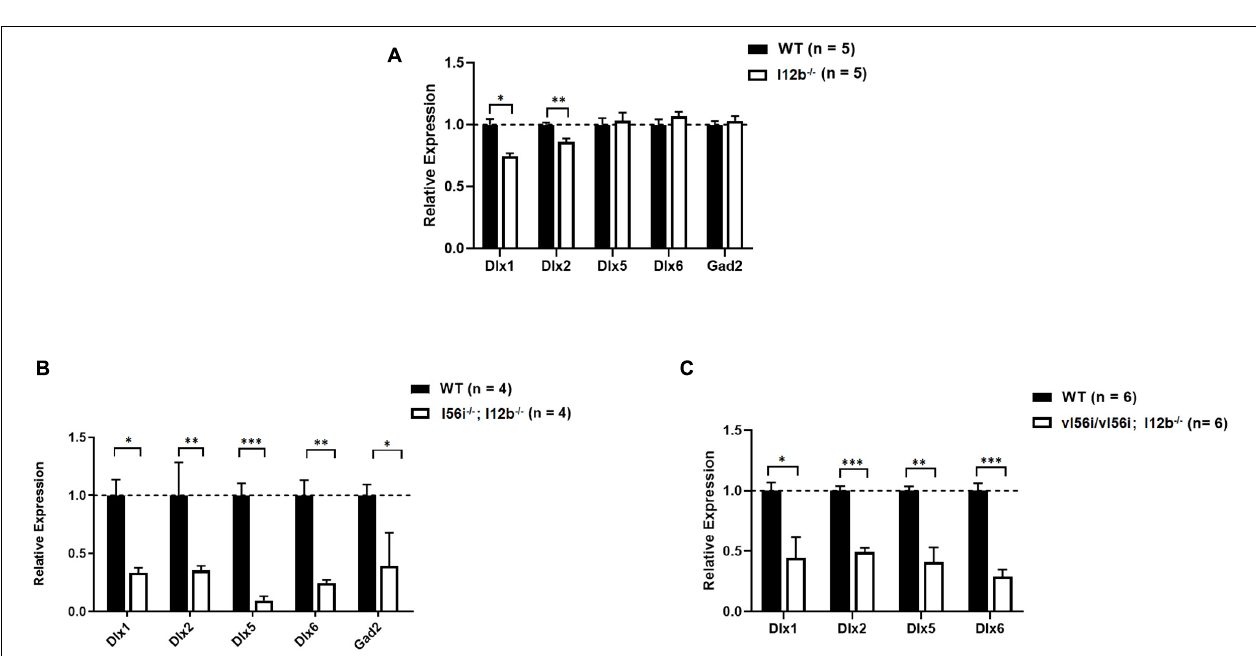
FIGURE 3 | Dlx expression is reduced in the developing forebrain of mice homozygous for a variant I56i enhancer. (A–C,A (cid:48) –C (cid:48) ) In situ hybridization on forebrain for Dlx5 at (A,A (cid:48) ) E11.5, (B,B (cid:48) ) E13.5 rostral slice, and (C,C (cid:48) ) E13.5 caudal slice. (A–C) WT mice and (A (cid:48) –C (cid:48) ) homozygous vI56i mice. Scale bar = 1 mm (A,A (cid:48) ) and 1 mm (B,C,B (cid:48) ,C (cid:48) ) . LGE, lateral ganglionic eminence; MGE, median ganglionic eminence; CGE, caudal ganglionic eminence; Di, diencephalon. (D–F) qRT-PCR of ventral telencephalon isolated from WT and homozygous vI56i mice. (D) E11.5, (E) E13.5, and (F) P0. WT (black), homozygous vI56i (white). Data presented as mean for the n values listed in brackets. Error bars represent SEM. Data analyzed using a two tailed t -test (* p < 0.05).